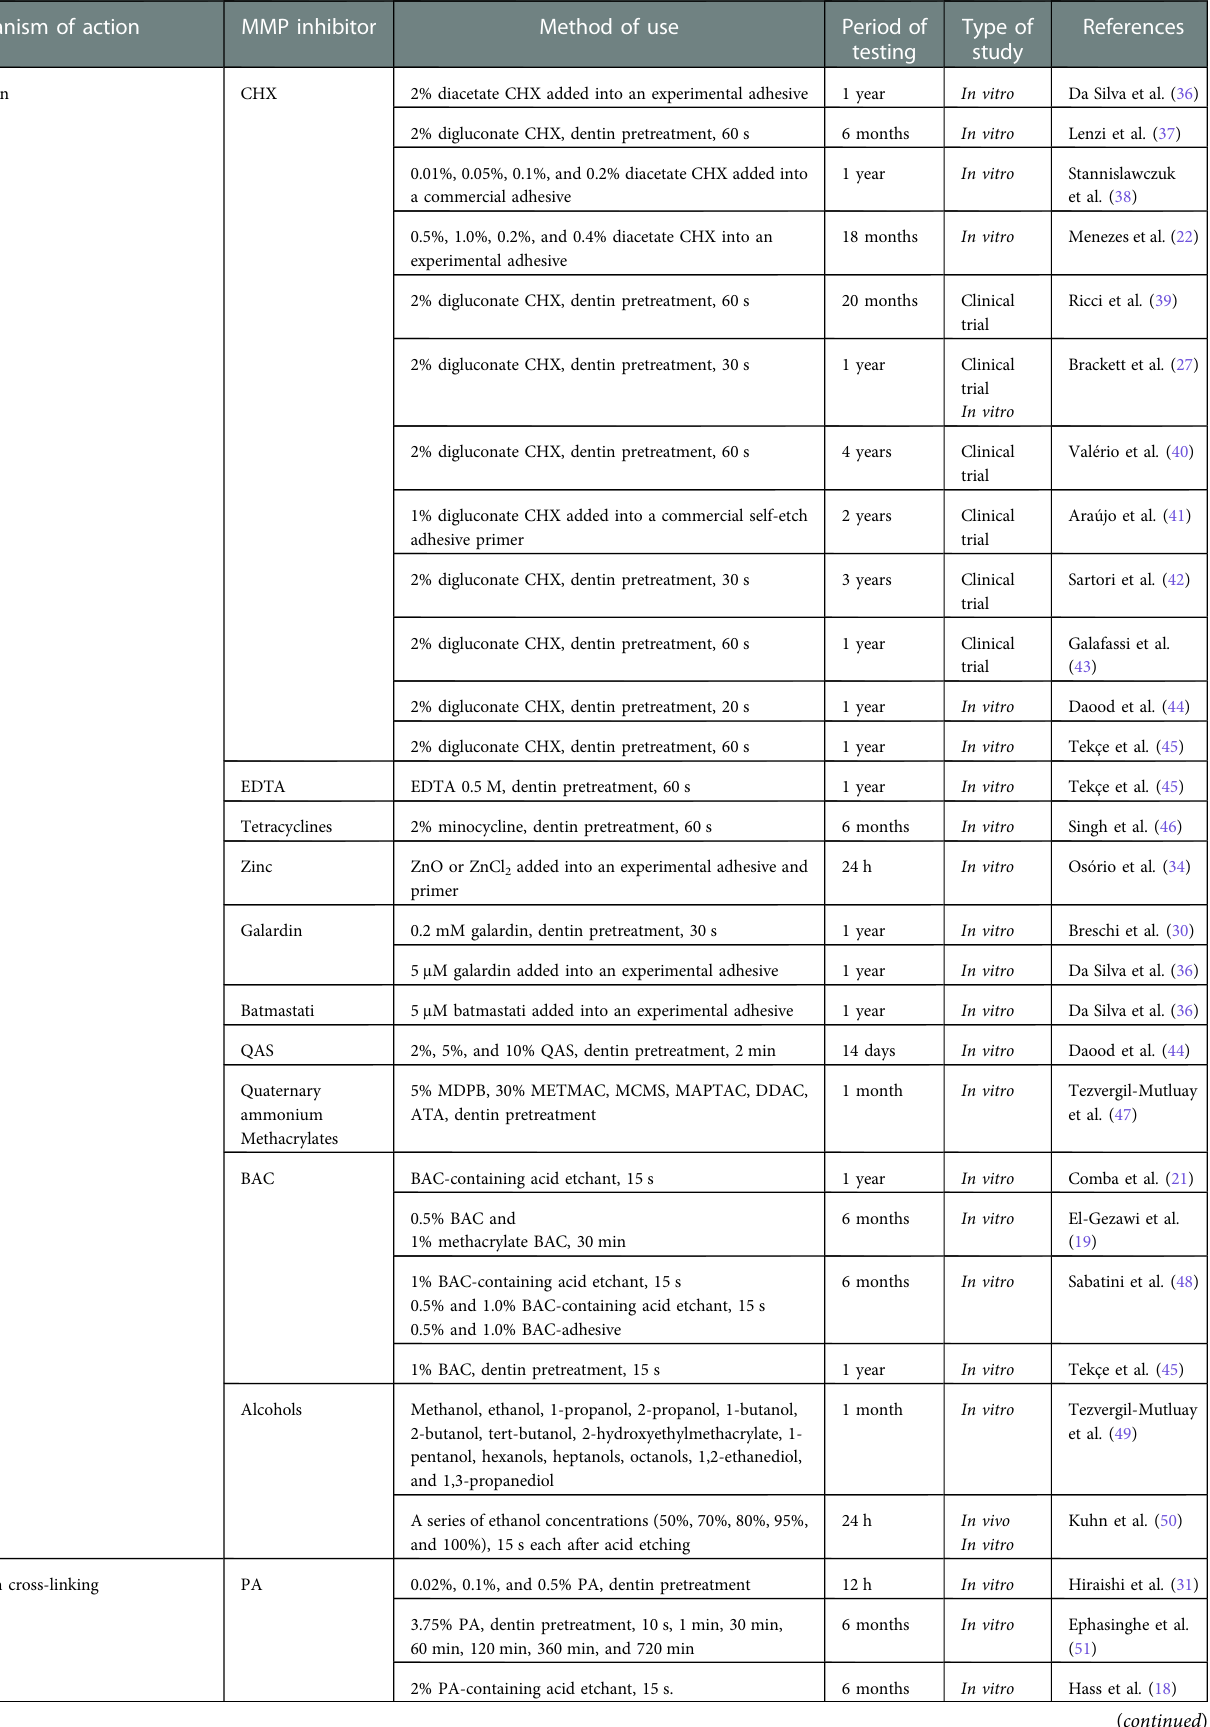
TABLE 1 Matrix metalloproteinases inhibitors and strategies to improve the stability of the dentin/resin bonding [Moraes et al (35)] a